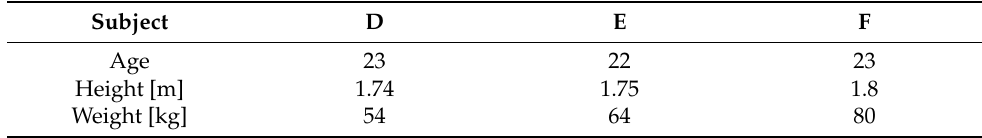
Table 5. Subject information in the assist evaluation of the gait